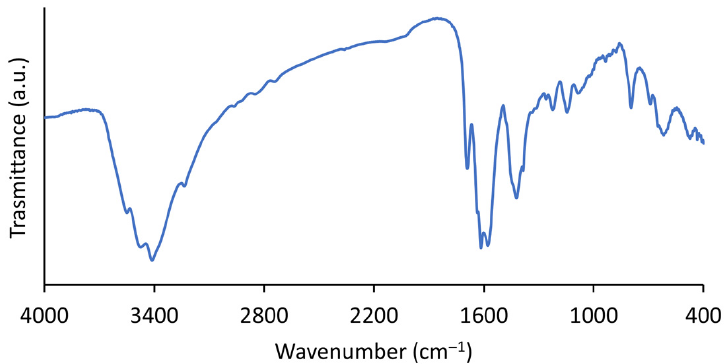
Figure 2. FTIR spectra of the i ‐ POF.